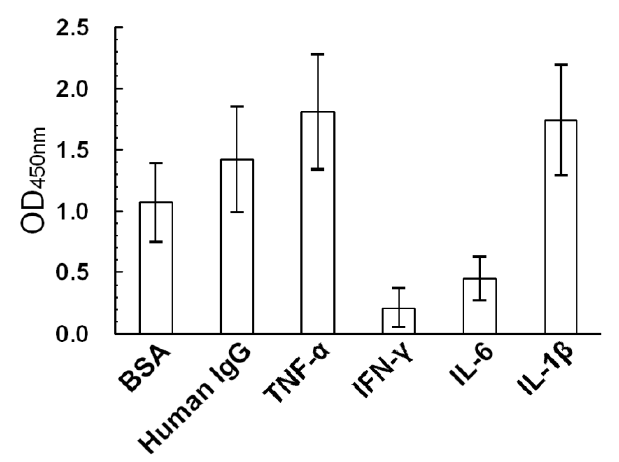
Figure 1. Binding capacity of THP (10 μ g/mL) for different proteins including